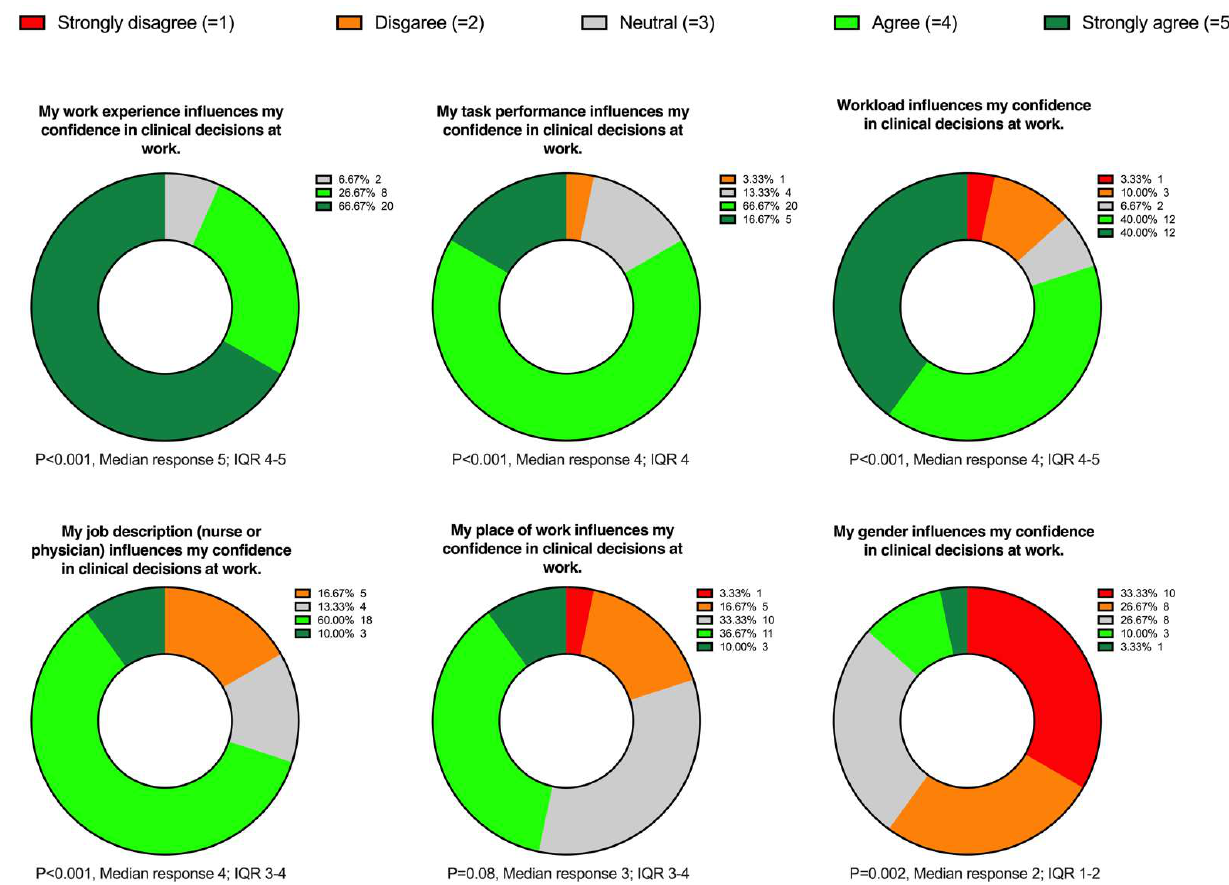
Figure 3. Part-of-whole donut charts display the ratings concerning the six statements of the online survey. Results are shown as numbers and percentages. We used the one-sample Wilcoxon signed- rank test to determine whether the answers differ from neutral ( p < 0.05). N = 30 for each